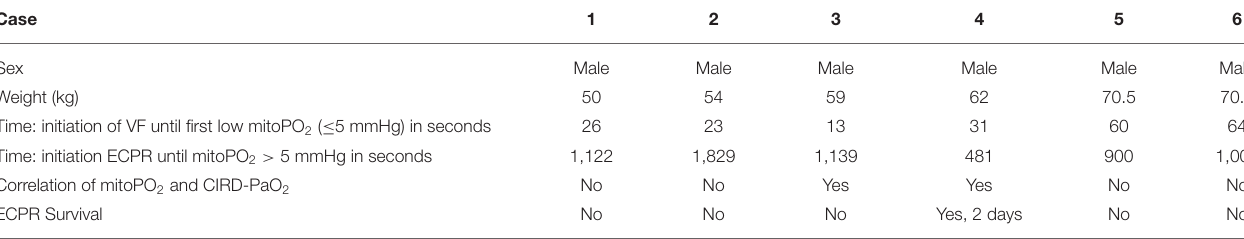
TABLE 1 | Individual characteristics of measurements in six experimental pigs.